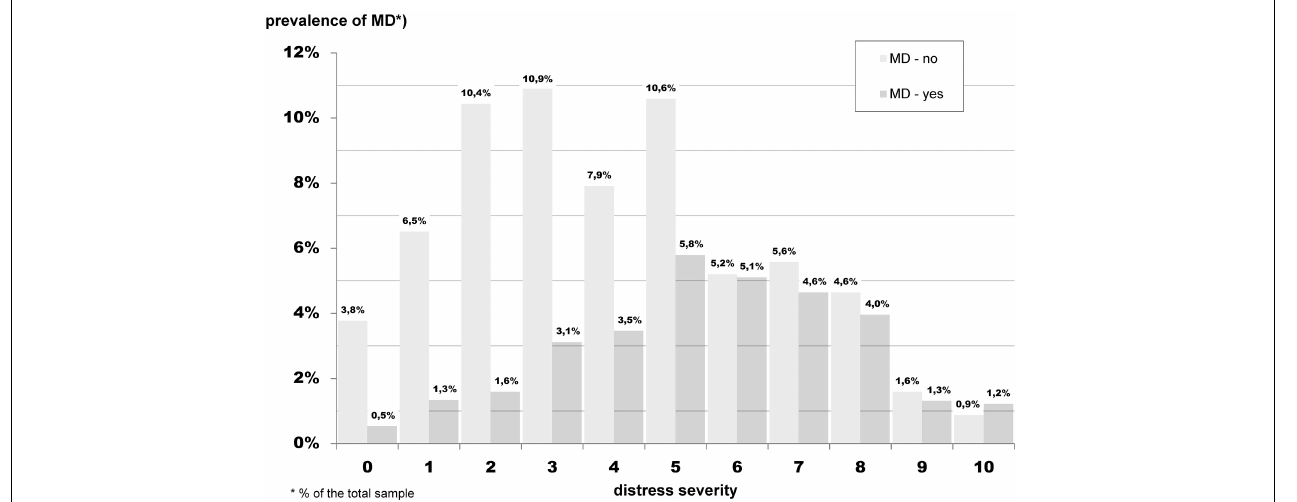
FIGURE 2 | Frequency of distress for patients with (dark gray) and without MD (light gray) for different levels of distress severity (weighed sample, N = 3,212).